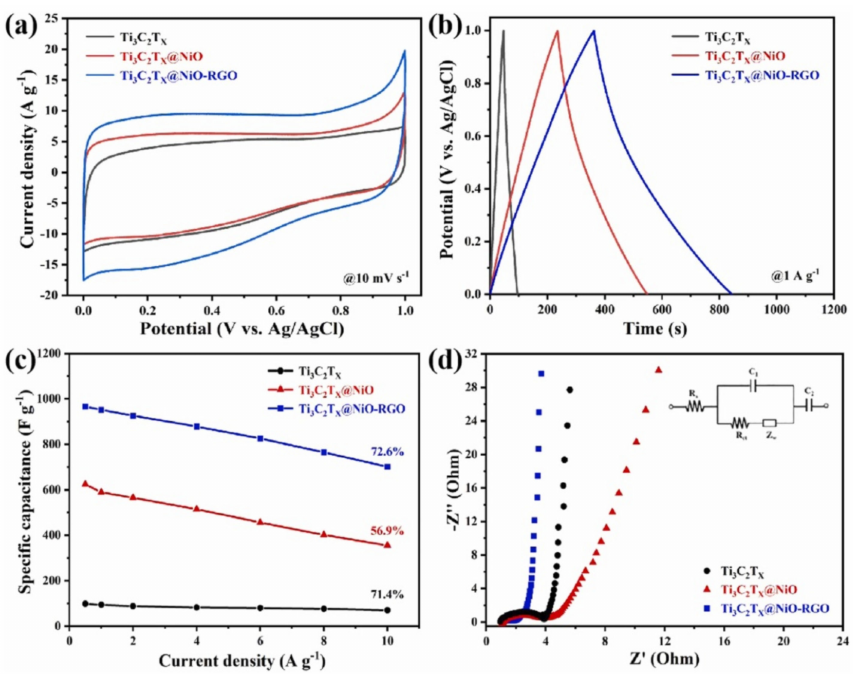
Figure 7. Application of MXene heterostructures in supercapacitors. ( a ) CV curves of Ti 3 C 2 T x , Ti 3 C 2 T x @NiO and Ti 3 C 2 T x @NiO − RGO hydrogel at the potential scan rate of 10mV · s − 1 . ( b ) GCD curves of Ti 3 C 2 T x , Ti 3 C 2 T x @NiO and Ti 3 C 2 T x @NiO − RGO hydrogel at the current density of 1A · g − 1 . ( c ) Specific capacitance vs. current density plot of Ti 3 C 2 T x , Ti 3 C 2 T x @NiO and Ti 3 C 2 T x @NiO − RGO hydrogel. ( d ) Nyquist impedance plots of Ti 3 C 2 T x , Ti 3 C 2 T x @NiO and Ti 3 C 2 T x @NiO − RGO hydrogel at 0V, with the equivalent circuit shown in the insert. Reprinted with permission from Ref.